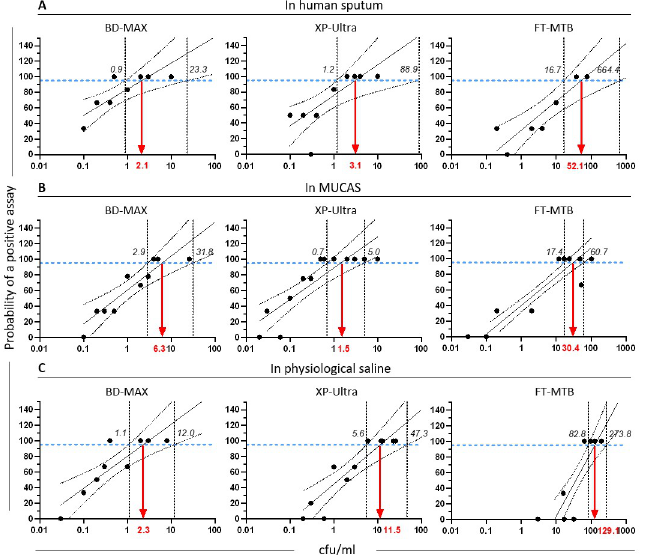
Fig 2. LoD 95TB of BD-MAX MDR-TB (BD-MAX), Xpert MTB/Rif Ultra (XP-Ultra) and FluoroType MTB (FT-MTB) in human sputum (A), MUCAS (B) and physiological saline solution (C). Red arrow: calculated LoD 95TB , solid black line: predicted positive assay, blue dashed line: 95% probability of a positive assay, black dashed lines: upper and lower CI 95